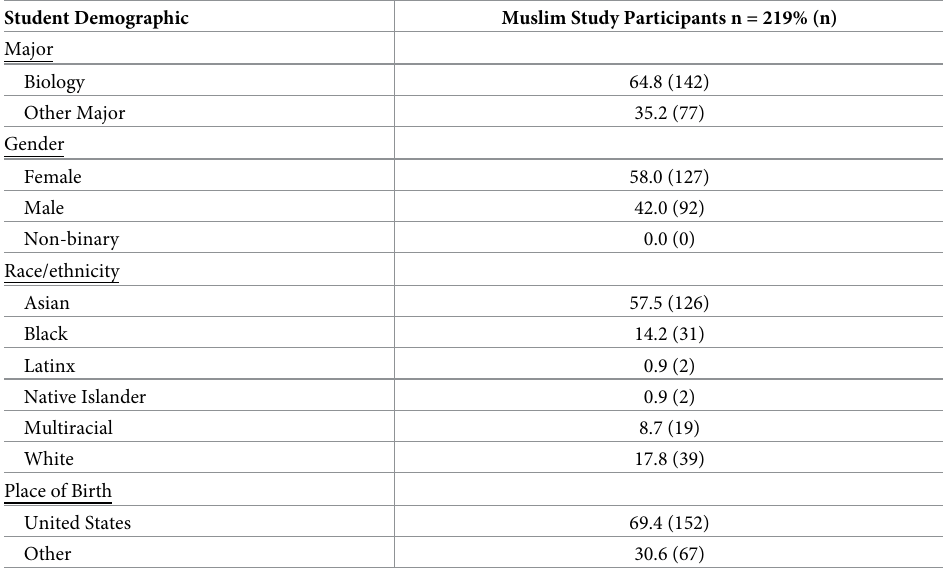
Table 2. The demographics of college biology Muslim student participants in this study.